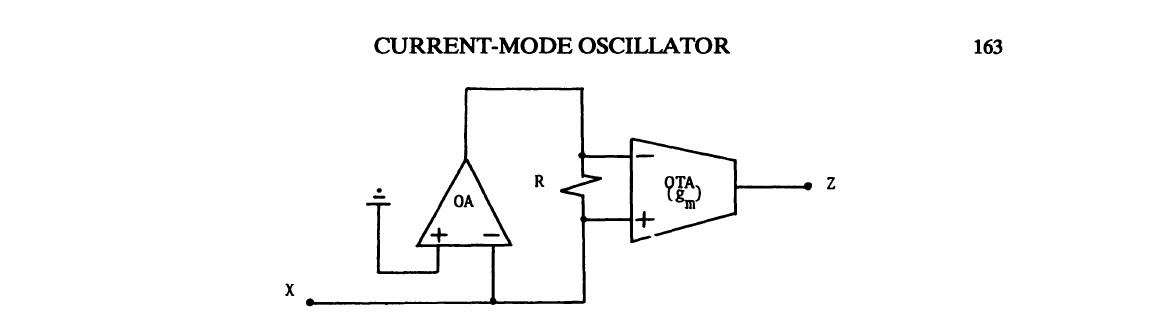
FIGURE 2 The circuit used for Simulating CF- R 1K, gm lmA/V.